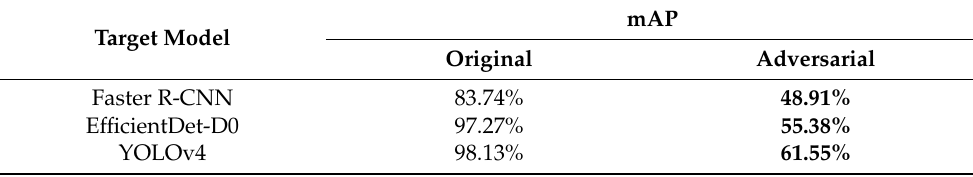
Table 8. mAP of target object detection models on normal images and adversarial examples.